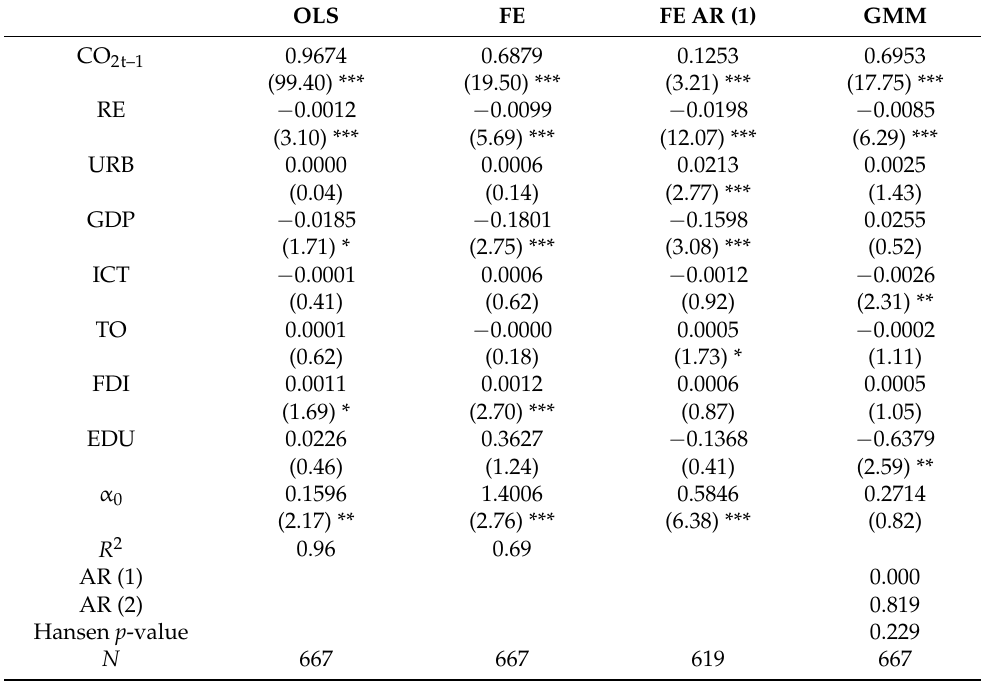
Table 3. Main results: CO 2 emissions (kg per 2010 USD of